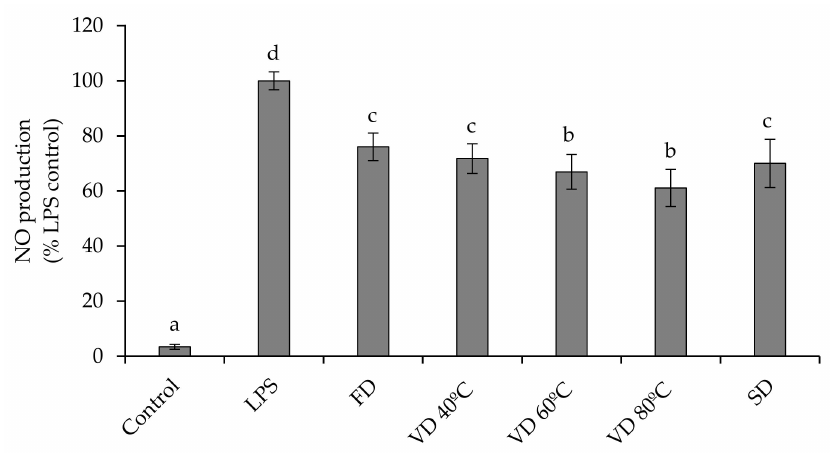
Figure 3. E ff ect of PEP (1 mg / mL) on nitric oxide (NO) production in LPS-stimulated RAW264.7 macrophage cells. Values are expressed as a percentage relative to the LPS-stimulated control group and are represented by mean ± SD ( n = 3). Bars with di ff erent letters indicate significant di ff erences on NO production by ANOVA LSD Tukey test ( p ≤ 0.05). Freeze drying (FD); Vacuum drying 40 ◦ C